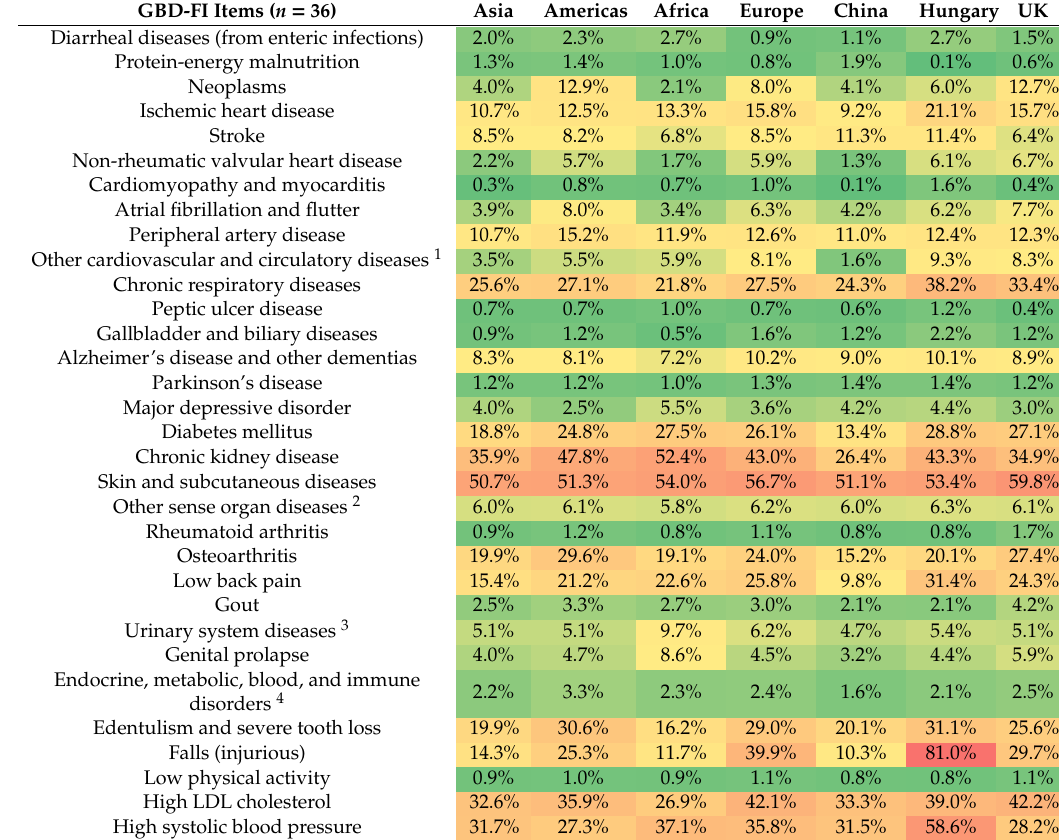
Figure 4. Mean Global Burden of Disease Frailty Index (GBD-FI) scores for 195 countries and territories in the GBD for the global population aged ≥ 70 years in 2017. Table 2. Global prevalence (%) of individual deficits ( n = 36) included in the GBD-FI for those aged ≥ 70 in 2017, compared by four world regions and the countries with the lowest and highest GBD-FI scores and the United